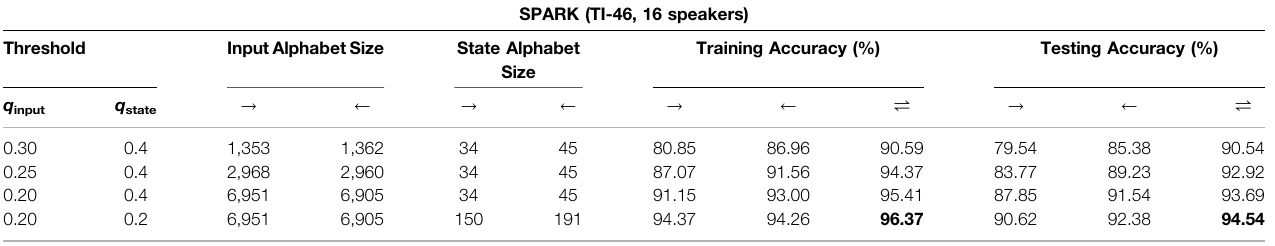
TABLE 5 | Performance comparison of SPARK (5-network KARMA chains) using pulse trains with other spike-based methods. SPARK (TI-46, 16